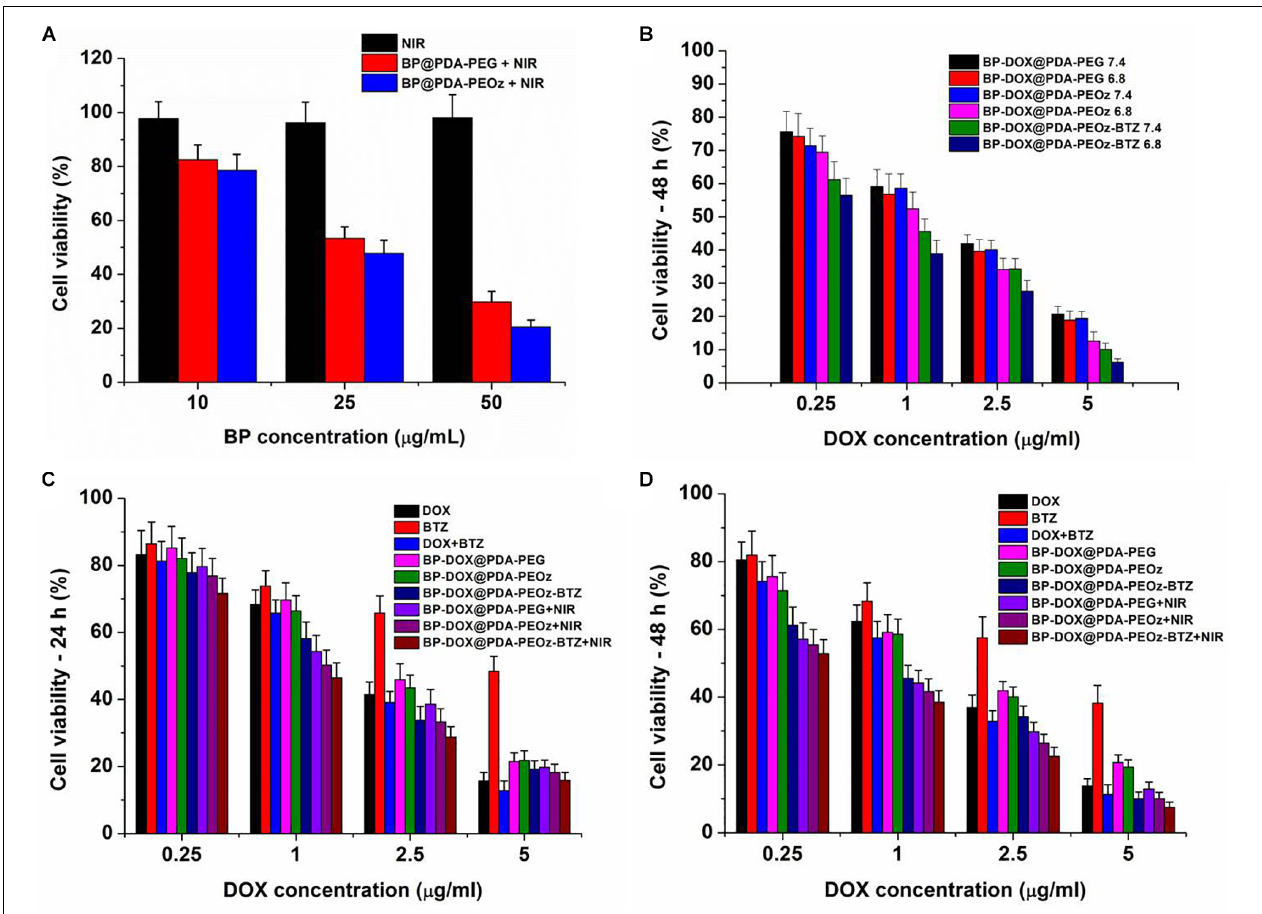
FIGURE 8 | Viability of MCF-7 cells cultured with (A) fresh culture medium, BP@PDA-PEG, BP@PDA-PEOz under NIR irradiation for 10 min. (B) Viability of MCF-7 cells cultured with BP-DOX@PDA-PEG, BP-DOX@PDA-PEOz, and BP-DOX@PDA-PEOz-BTZ in culture medium of different pH 7.4 or 6.8. Viability of MCF-7 cells cultured with DOX-loaded nanoformulations in comparison with DOX, BTZ, DOX + BTZ (1:1) and DOX-loaded nanosheets of BP-DOX@PDA-PEG, BP-DOX@PDA-PEOz, BP-DOX@PDA-PEOz-BTZ, BP-DOX@PDA-PEG + NIR, BP-DOX@PDA-PEOz + NIR, and BP-DOX@PDA-PEOz-BTZ + NIR at the same DOX dose: (C) 24 h, (D) 48